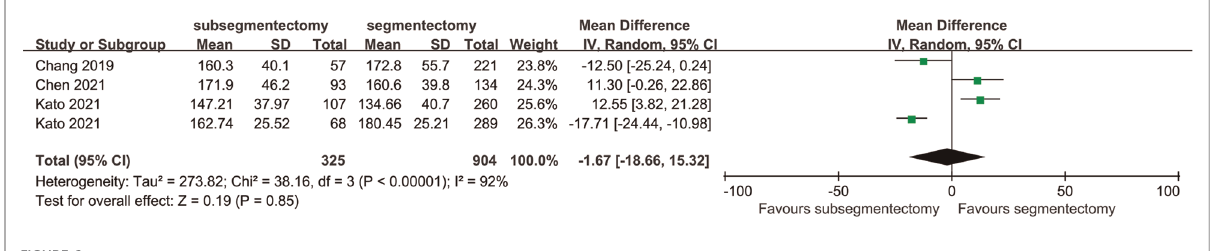
FIGURE 6 Forest plot: the operation time of subsegmentectomy vs.